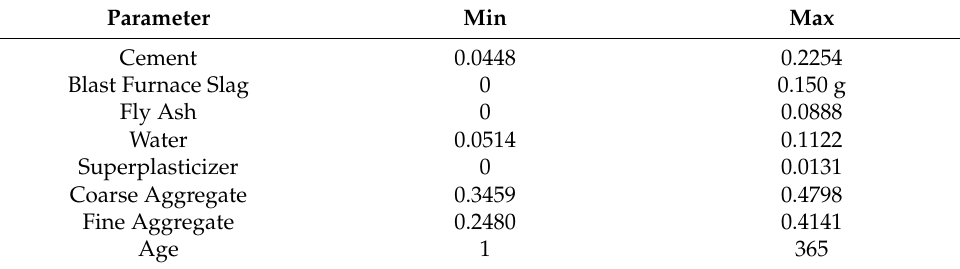
Table 3. Normalised data used for training artificial neural